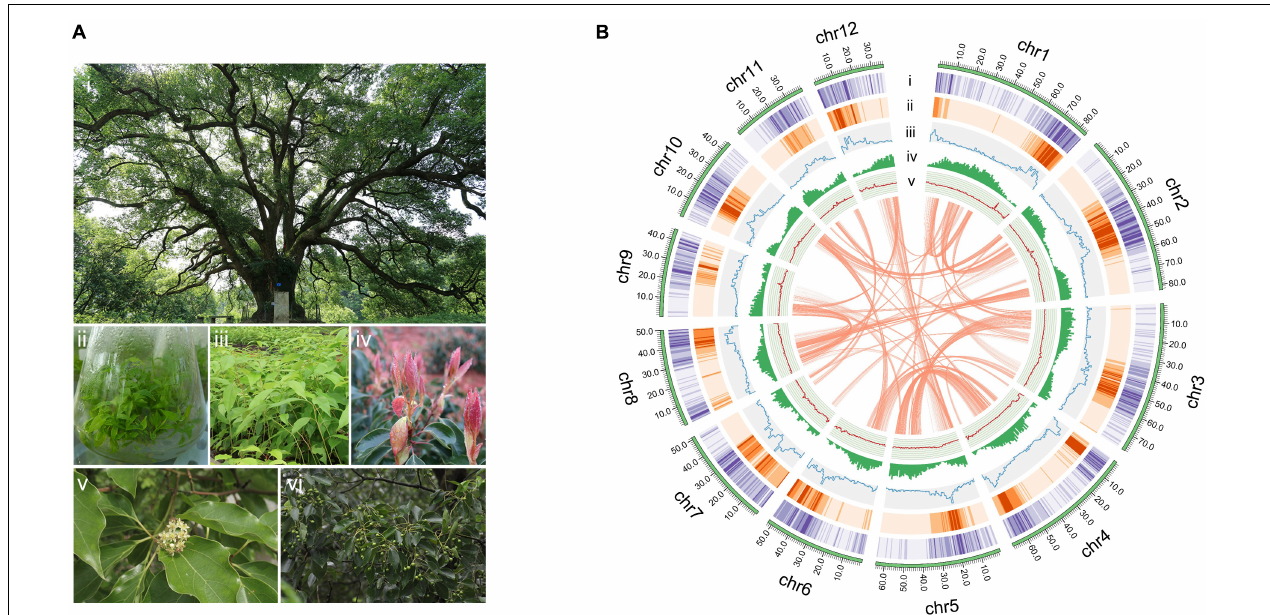
FIGURE 1 | The camphor tree and landscape of its genome. (A) Images of a camphor tree and its multiple tissues. (i) An ancient camphor tree, (ii) tissue-cultured seedings, (iii) seedings, (iv) young leaves, (v) flowers and (vi) fruits. (B) Circos plot of the C. camphora genome assembly. Circles from outside to inside: (i) chromosomes, (ii) Gypsy LTR density, (iii) Copia LTR density, (iii) total LTR density, (iv) gene density and (v) GC content. These density metrics were calculated with 1 Mb non-overlapped sliding windows. The syntenic genomic blocks ( > 300 kb) are illustrated with orange